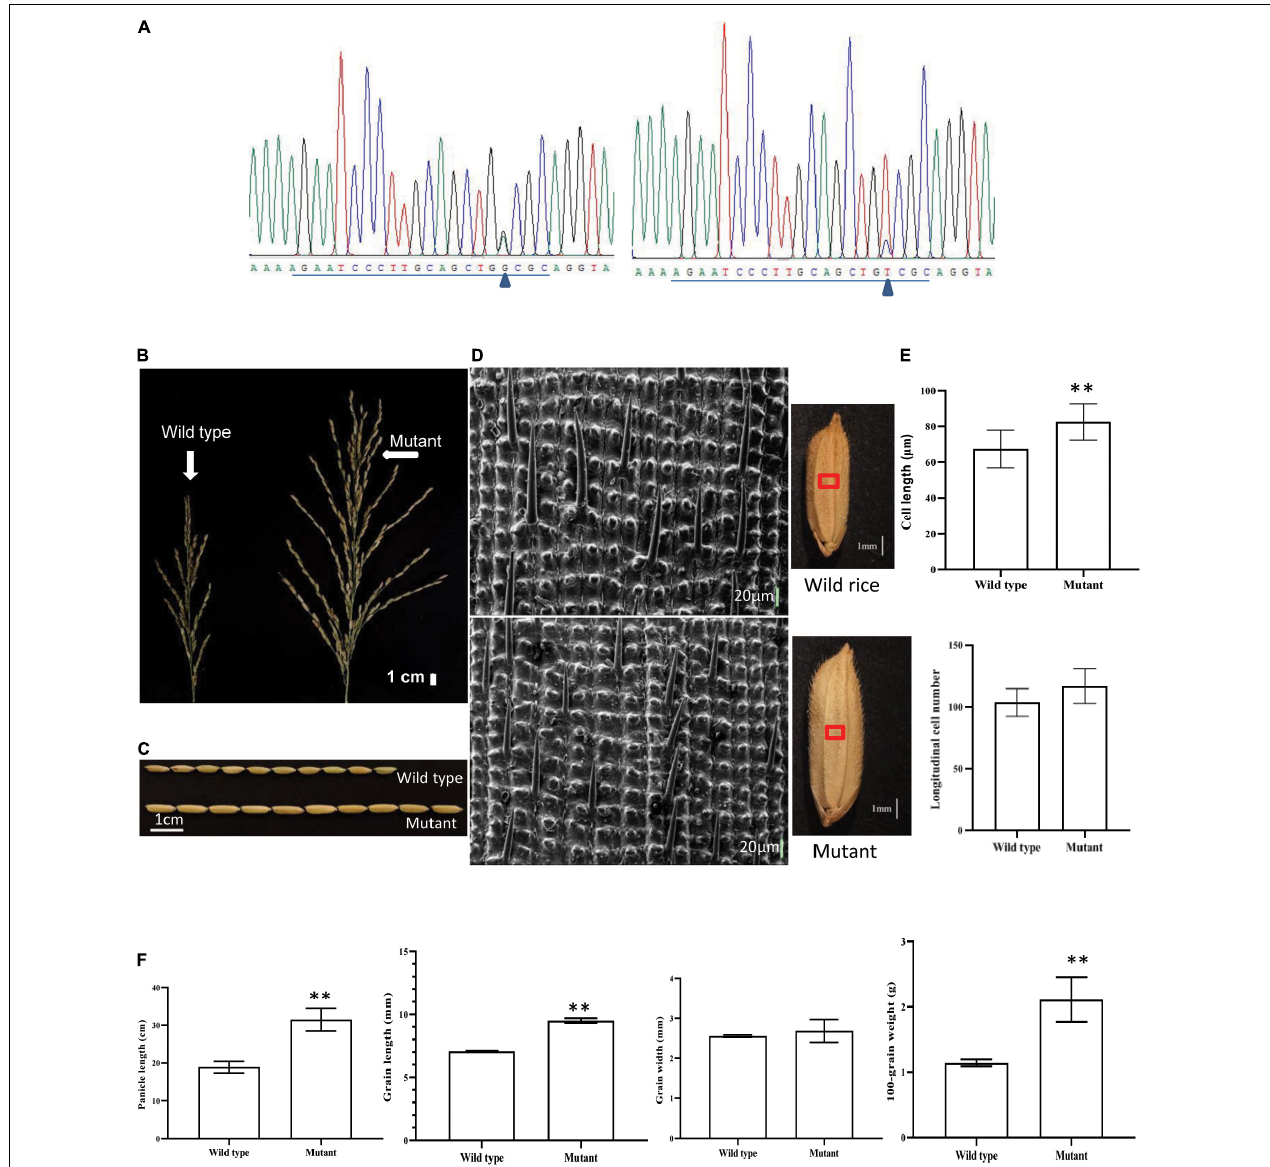
FIGURE 5 | Phenotypic and genotypic analyses of T 0 and T 1 generations after the knockout of ORF18 of Huaye 3 using CRISPR/Cas9 editing technology. (A) Target site 1 derived from mutants generated two edited types: one was a base insertion of G or A, and the other was a base insertion of T or C; “ (cid:49) ” indicated the variant base, and the underlined sequences are the target site. (B) Spike shape analysis of the wild type and mutant. (C) Comparison of the grain length between the wild type and mutant. (D) Comparison of the longitudinal cells of the grain outer glumes between the wild type and mutant. (E) Comparison of the cell length and longitudinal cell numbers between the wild type and mutant. (F) Analyses of the differences in the panicle, grain length, grain width, and 100-grain weight between the wild type and mutant. “ ∗∗ ” indicates a highly significant difference at the P = 0.01